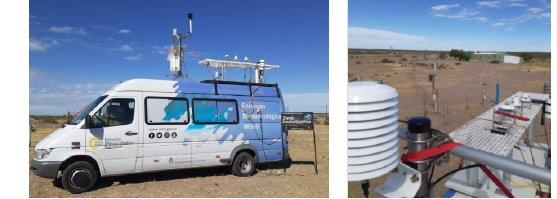
Figure 1: Totality path of the Dec 14th, 2020 solar eclipse. Valcheta is located just about 1 km from the center line and about 100 km from the Greatest eclipse point (black sun) 1 .